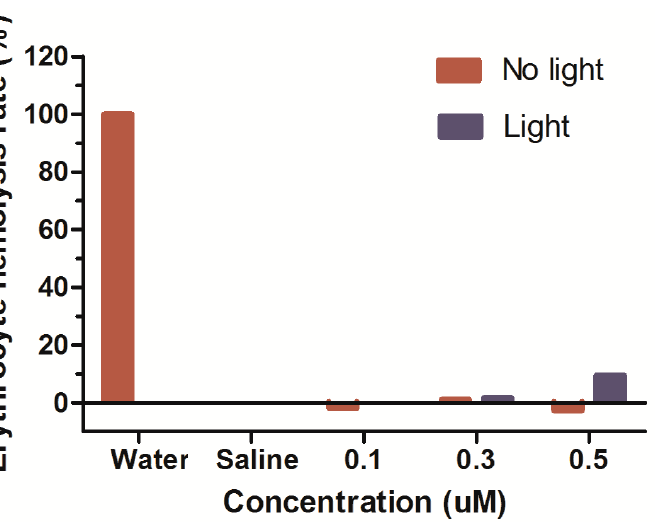
Figure 6. Study of the hemolytic effect of CPZ-GGG(RW)3 under LED red light illumination and in dark control against human erythrocytes.